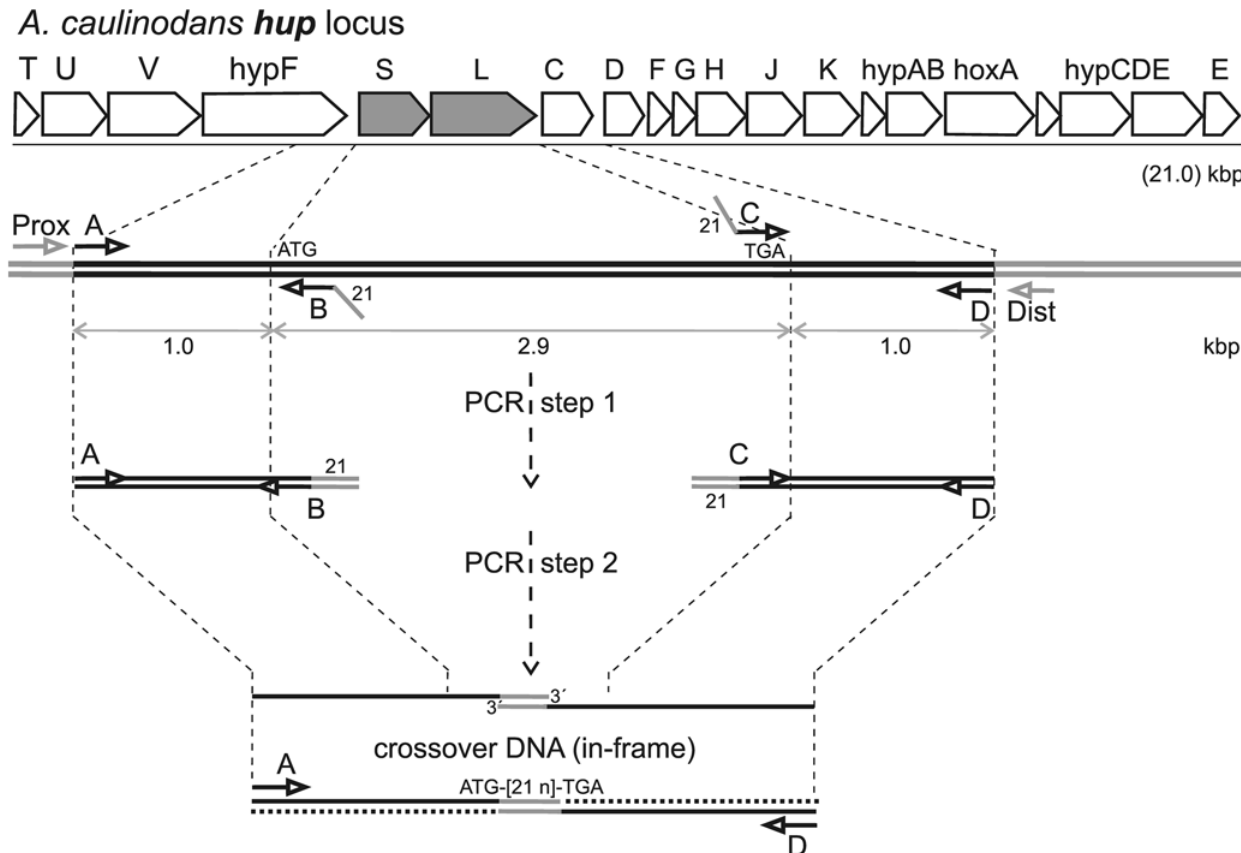
Figure 1. A.caulinodanshup genetic locus and physical map: creation of in-frame translational fusion deletions. The top line represents the genetic map of the 20-gene hup polycistronic operon spanning 21 kbp. The second line represents an expanded physical map of hupSL DNA indicating postions of and (5 9 R 3 9 ) polarity for synthetic A, B, C, and D oligodeoxynucleotide primers of genome-identical sequence used in two, separate PCR reactions to generate DNA fragments A R B and C R D. The third line indicates a follow-up PCR reaction in which DNA fragments A R B and C R D were mixed, thermally denatured, allowed to partially renature, and used as combination PCR template/primer. As synthetic primers B and C share a complementary 21 bp extension sequence (angled line), the A R B Watson and C R D Crick strands (and vice versa ) may partially reanneal via this 21 bp linker sequence In the third line, when such occurs, the resulting, partially-reannealed A R B(21 bp)C R D spliced DNA fragment which carries 5 9 -overhangs and free 3 9 -ends on both strands is a template for the thermostable DNA polymerase elongation reaction, producing a finished A R D duplex DNA fragment which may then be further amplified by PCR in the presence of added A and D primers. As verified by DNA sequencing analysis, finished, amplified A R D duplex fragments carry a genetic crossover which fuses (via the 21 bp linker sequence) in-frame the ‘‘start’’ codon of the proximal hupS gene to the ‘‘stop’’ codon of the distal hupL gene. Primers A and D may be extended with genome non-complementary elements to facilitate molecular cloning of resulting A R D fragments (Table 1). In vivo using homologous genetic recombination, wild-type loci are then exchanged for recombinant A R D crossover DNA fragments, which yield in-frame, translational deletion alleles of target genes of interest